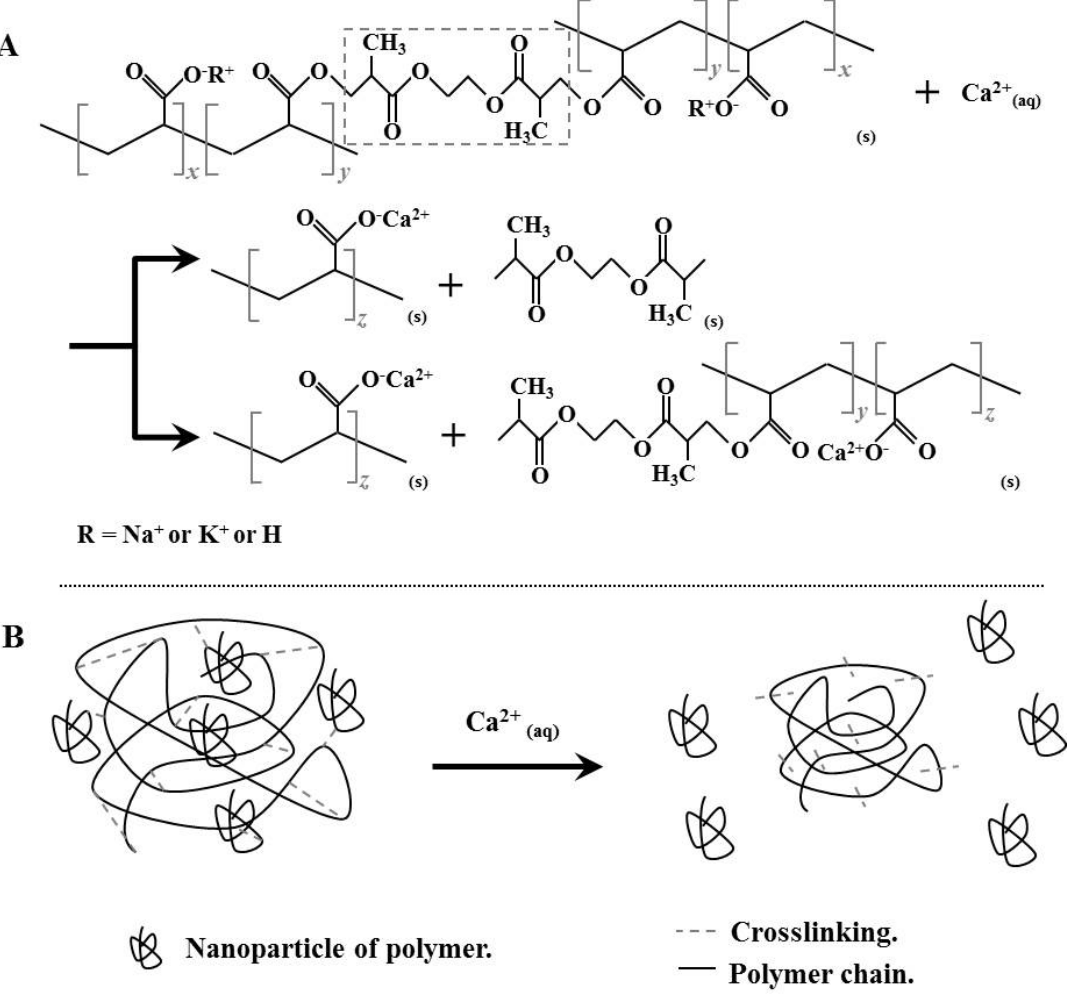
Figure 11. Schematic representation of the effects of solutions associated with calcium ions in commercial hydrogels. ( A ) Schematic representation of the degradation of the polymers, ( B ) Schematic representation of the generation of nanoparticles by crosslinking breaking.